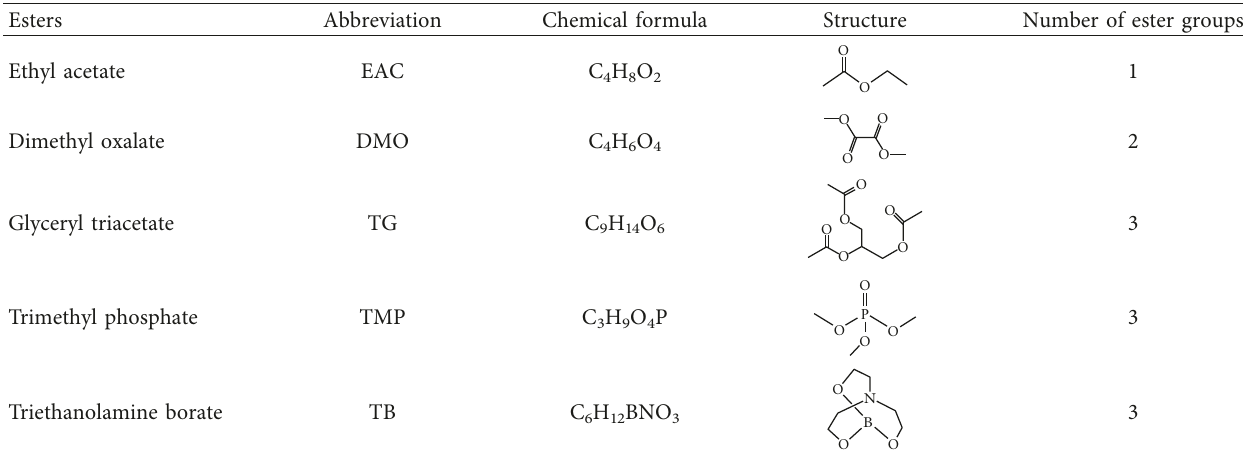
Table 3: Basic information of five kinds of ester